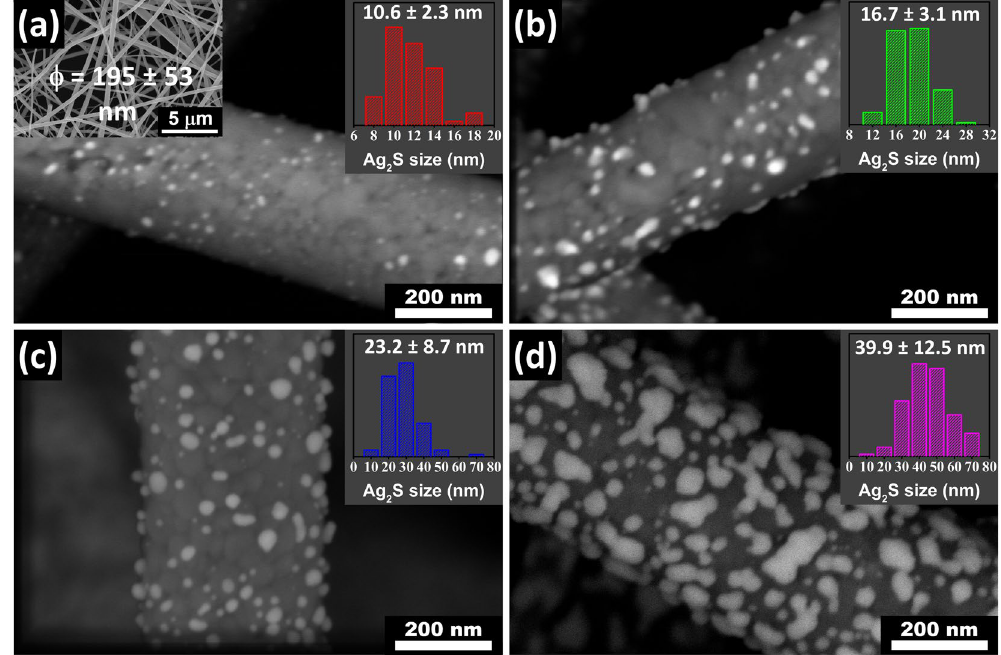
Figure 1. High resolution SEM images of Ag 2 S@TiO 2 NFs with mean Ag 2 S size of ( a ) 11 nm, ( b ) 17 nm, ( c ) 23 nm and ( d ) 40 nm. The Ag 2 S size distribution is shown in the insets. A low magnification SEM image of the TiO 2 NFs is also shown as inset in ( a ).